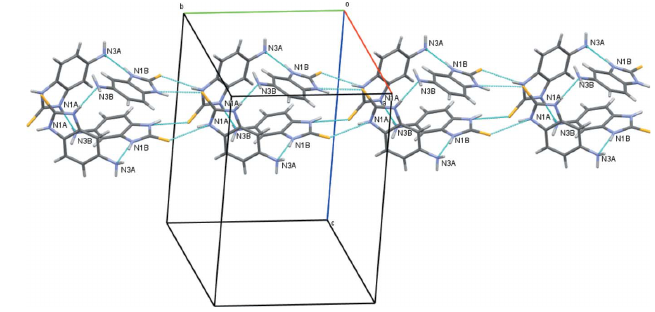
Figure 3 Chain/tube of tetramers linked by N1 A (cid:2)(cid:2)(cid:2) H1 NA —N3 B and N1 B— H1 NB (cid:2)(cid:2)(cid:2) N3 A hydrogen